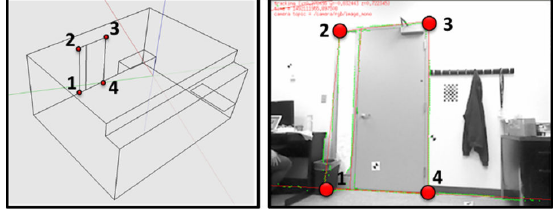
Figure 2. Example of ViSP’s initialization process. Left) 4 pre- specified 3D points on the wireframe model. Right) The user selects the 4 corresponding points on the image. ViSP uses these corresponding points to estimate the first camera